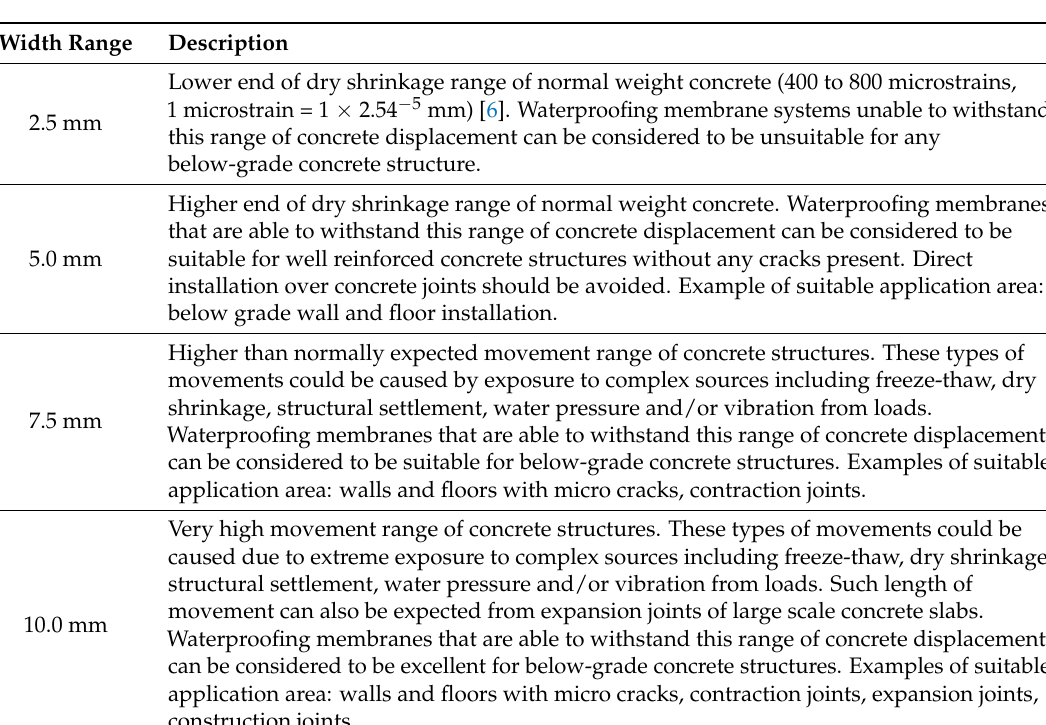
Crack/joint movement range in “Proposal on Composite Waterproofing Method Evaluation